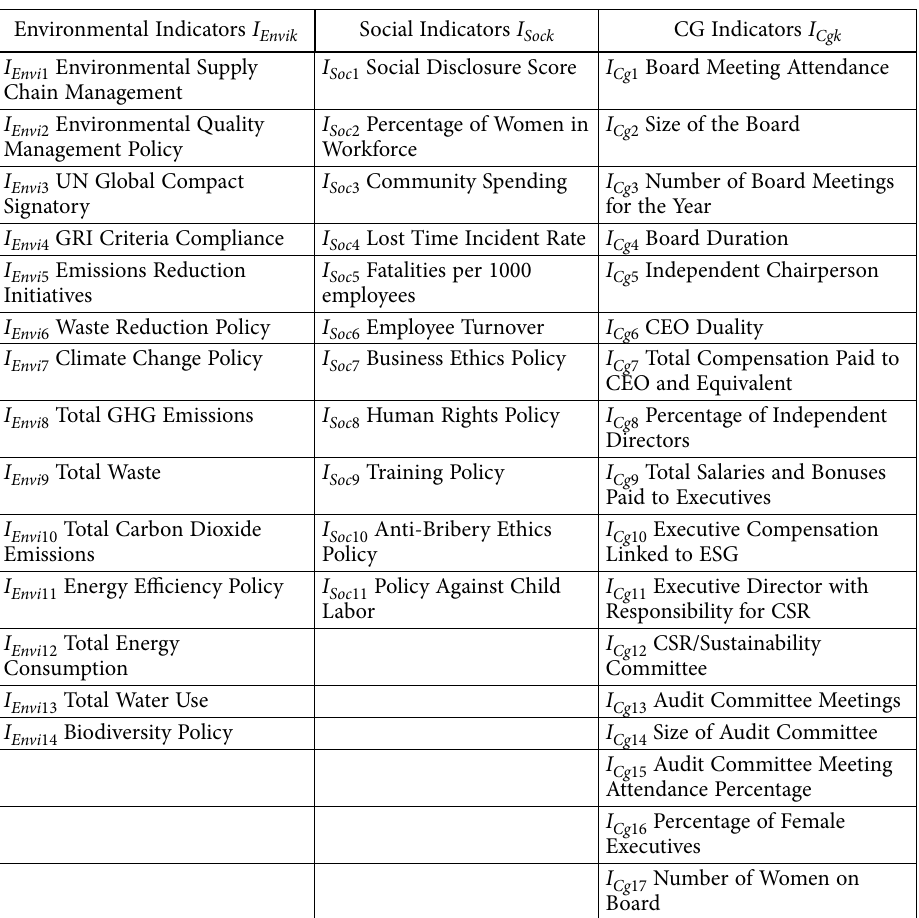
Table 2. A basic set of ESG indicators Environmental Indicators I Envik Social Indicators I